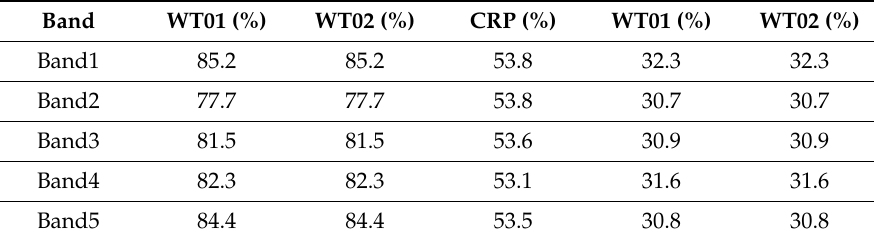
Table 3. Reflectance of five reference